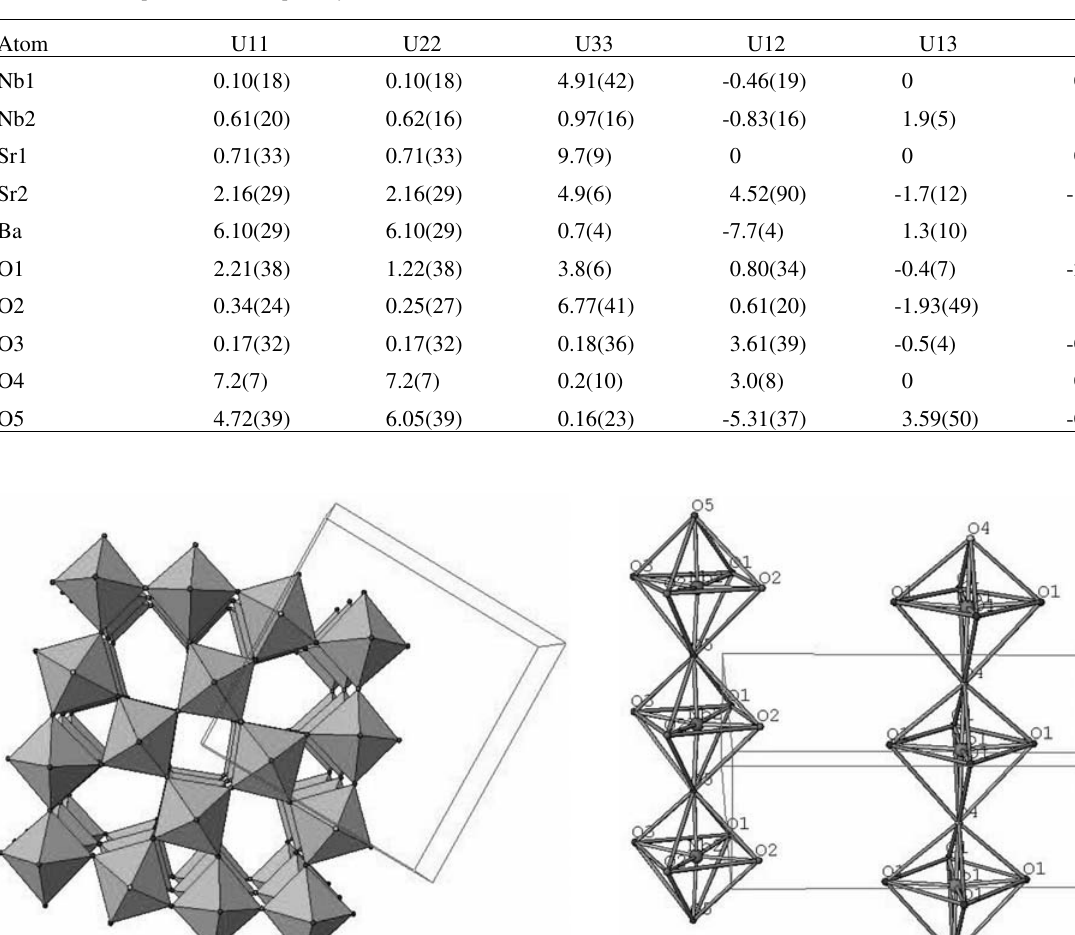
Table 3. Thermal parameters (multiplied by 100) for SBN ceramic refinement.